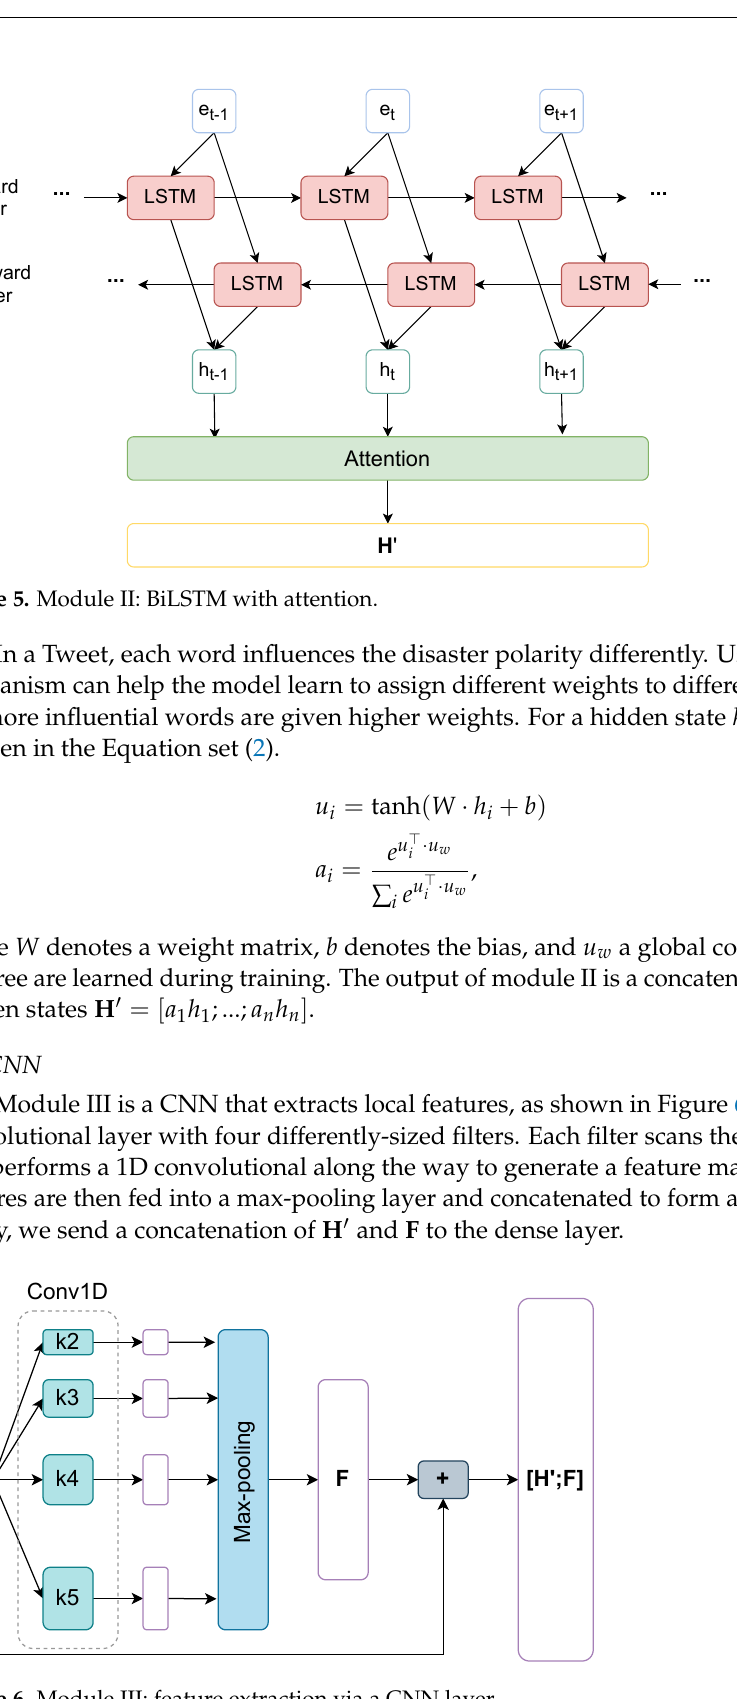
Figure 6. Module III: feature extraction via a CNN